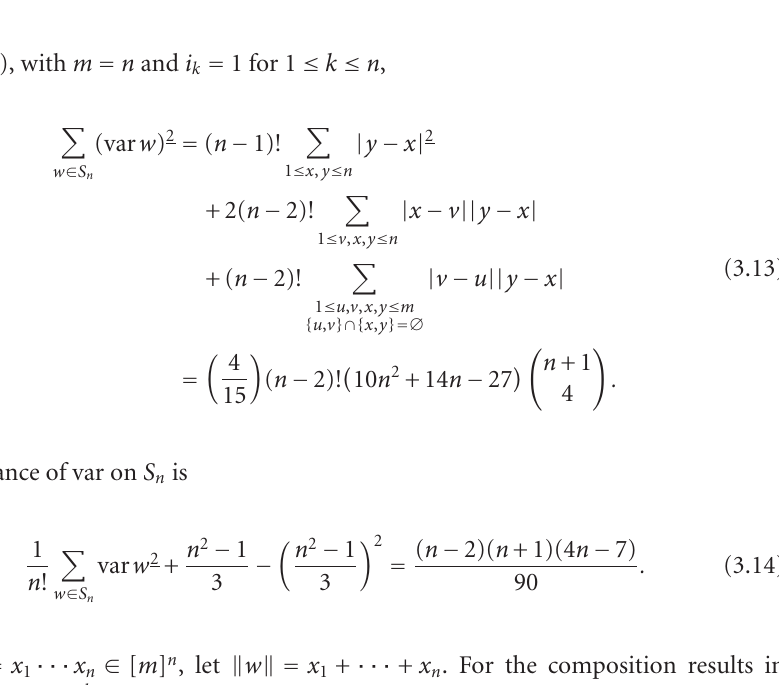
Table 1.1, set z k = q k for 1 ≤ k ≤ m . Then (2.13) implies